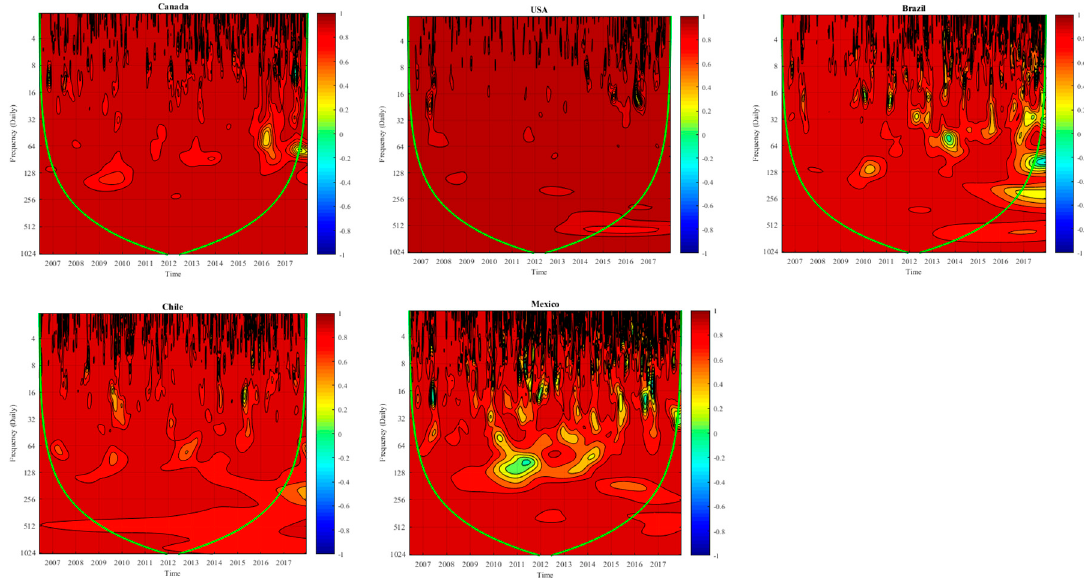
Figure A4. Islamic-conventional stock returns Wavelet correlations for Americas’ region markets.